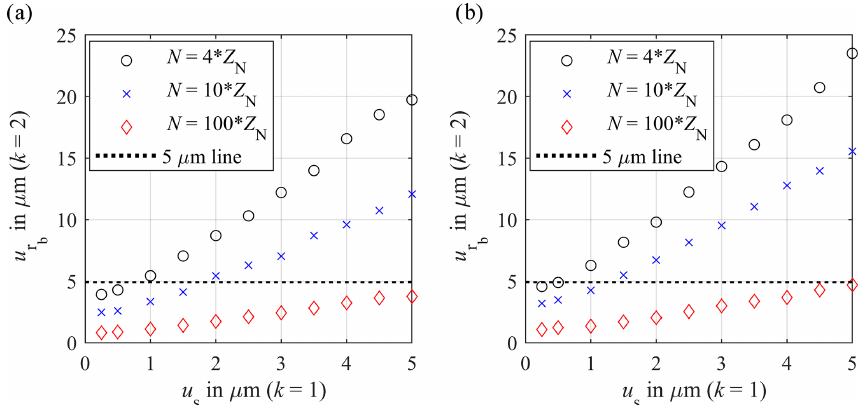
Figure 4. Random error of the mean base circle radius for the single sensor approach for k = 2 for (a) a small gear with a nominal base circle radius of 45.810mm and 26 teeth and (b) a large gear with a nominal base circle radius of 904.924mm and 107 teeth depending on the sensor uncertainty ( k = 1) and number of measuring points N in comparison with the required uncertainty of 5µm ( k =